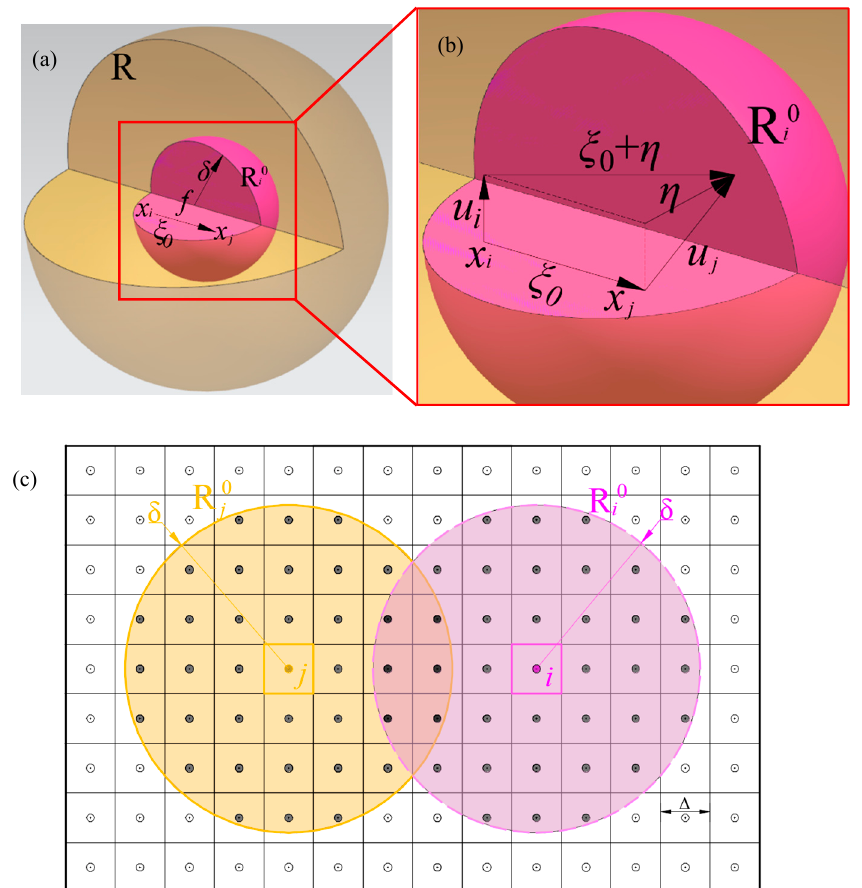
Figure 1. Interaction and motion state between material points: ( a ) reference domain and reference subdomain, ( b ) motion vector relation of material point and ( c ) interaction between material points in near-field.